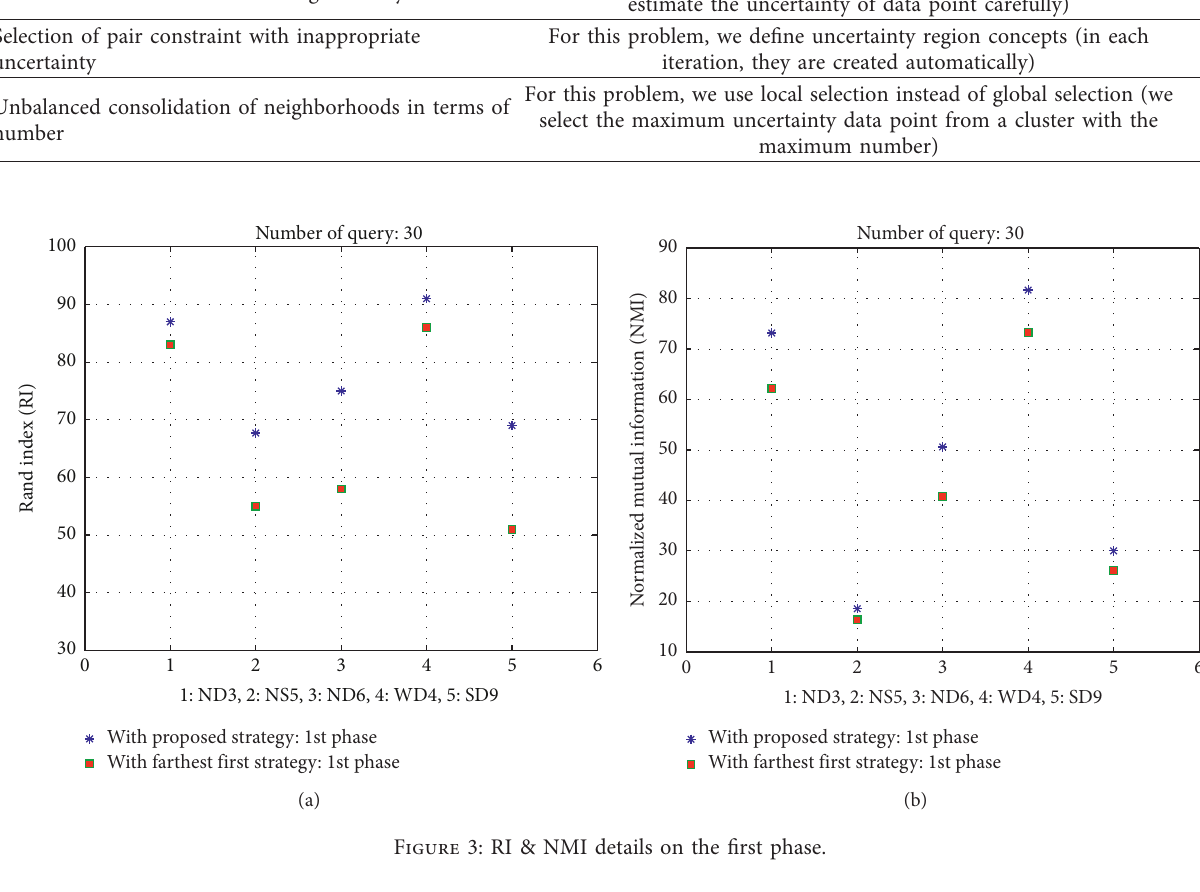
Figure 3: RI & NMI details on the first